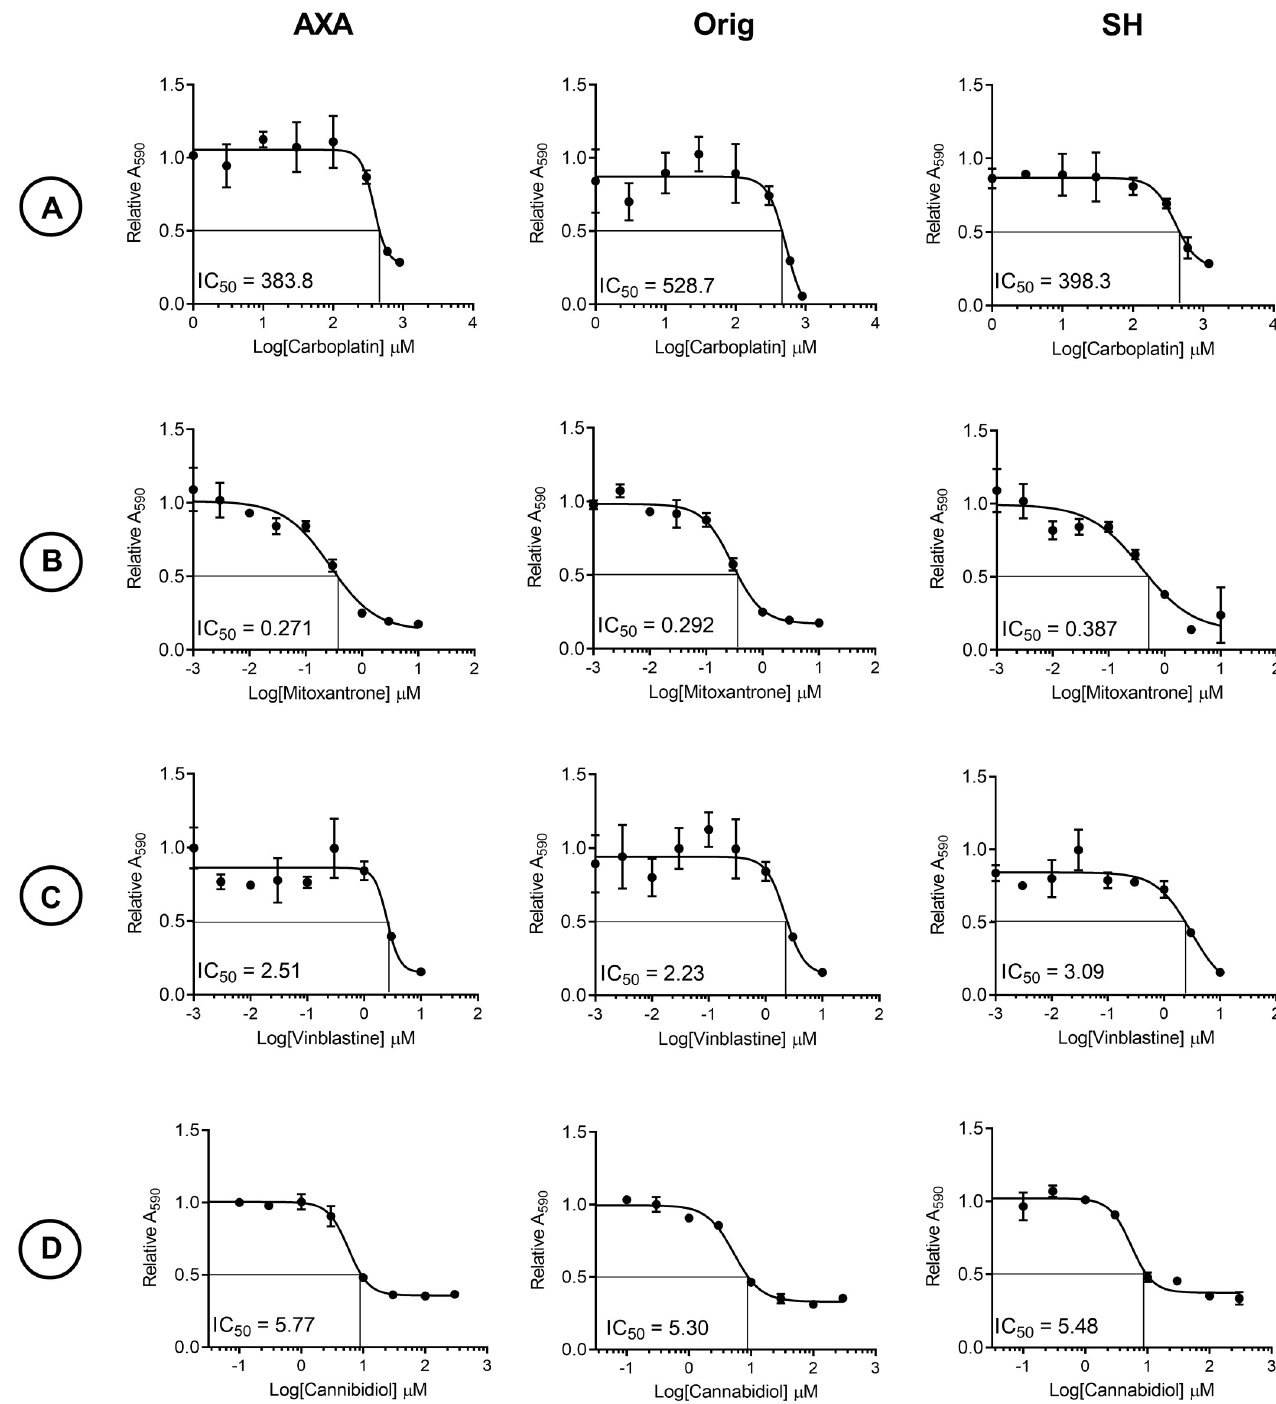
Fig 1. Dose-dependent decreases in cell viability with carboplatin, mitoxantrone, vinblastine, and CBD treatment of canine UC cells. Representative IC50 curves of cells treated with increasing doses of (A) carboplatin, (B) mitoxantrone, (C) vinblastine, and (D) CBD for 24 hours. IC50 values from graphs represent mean ± SD of three technical replicates and three biological replicates from each cell line.